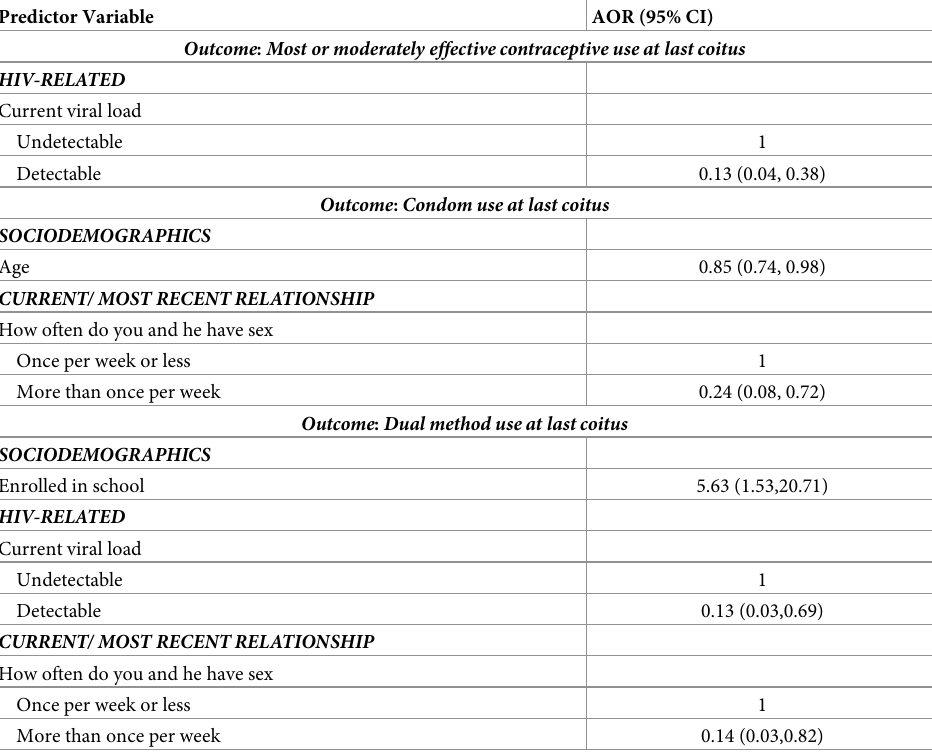
model (Table 5), older age (aOR 0.85, 95% CI [0.74,0.98]) and more frequent coitus ( > once/ week versus < = once/week; aOR 0.24, 95% CI [0.08, 0.72]) remained significantly associated with reduced odds of condom use. Table 5. Multivariable Models for most or moderately effective contraception use, condom use and dual method